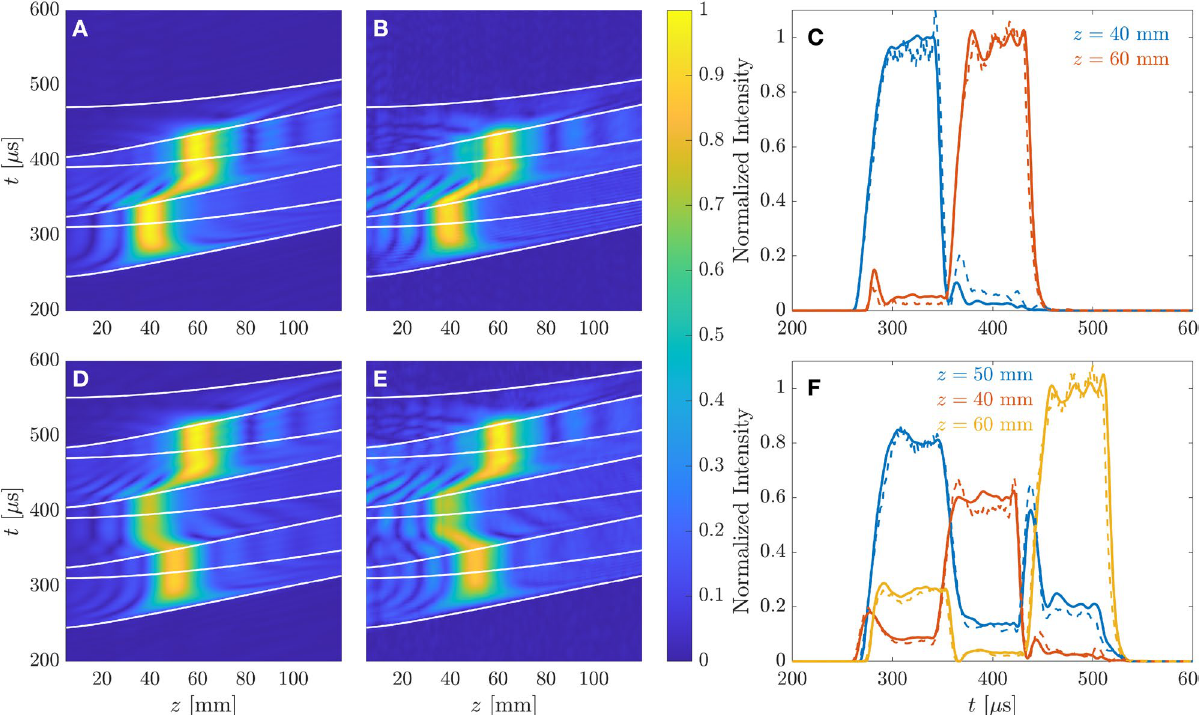
Figure 2. Simulated and measured results for the two waveforms depicted in Fig. 1C,D: ( A ) simulated and ( B ) measured pressure profile as a function of time using the two foci waveform, and ( C ) focal intensities as a function of time. ( D ) Simulated and ( E ) measured pressure profile as a function of time using the three foci waveform, and ( F ) focal intensities as a function of time. White lines in ( A ), ( B ), ( D ), and ( E ) represent the beginning and ending of transient states. In ( C ) and ( F ), solid lines represent simulation results, while dashed lines are for